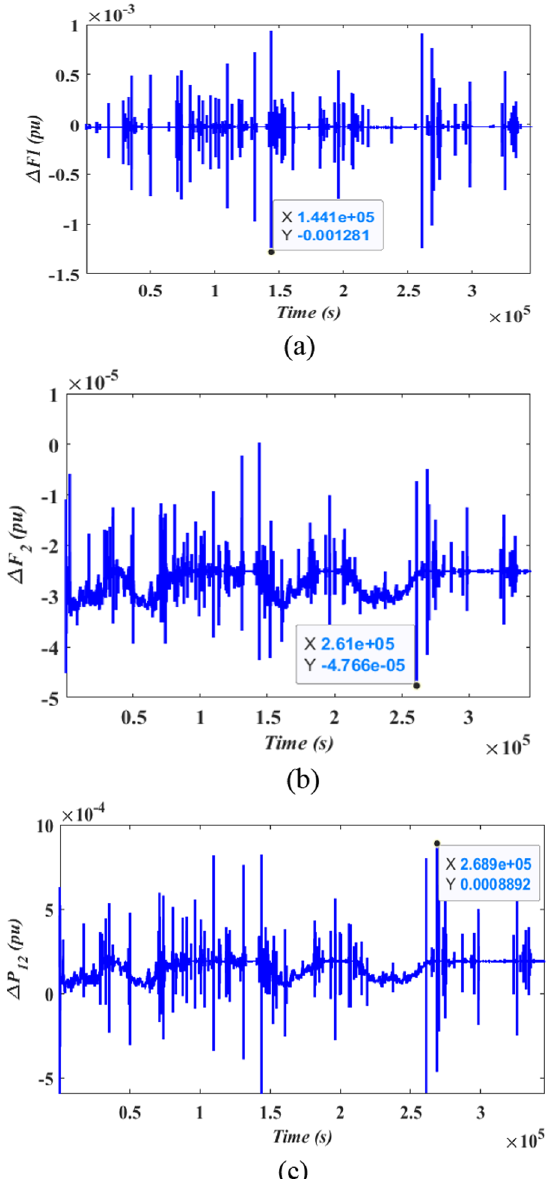
Fig. 14 System responses due to real weather conditions a (cid:31) F 1 , b (cid:31) F 2 , c (cid:31) P